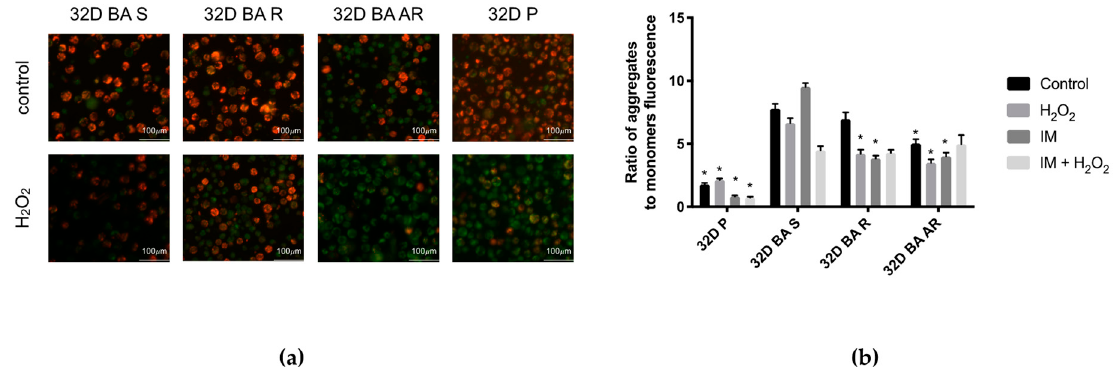
Figure 3. Mitochondrial membrane potential in BCR-ABL1 cells. ( a ) Photos showing leukemic and wild-type, non-cancer cells under different conditions of treatment: control and after 30-min exposure to H 2 O 2 . We stained the cells with cationic dye JC-1 that accumulates in the mitochondrial membrane in a potential-dependent manner. A high potential of the inner mitochondrial membrane leads to the formation of dye aggregates with both excitation and emission shifted towards the red light (530 nm/590 nm), while respective values for JC-1 monomers are 485 nm/538 nm; ( b ) A comparison of the measured ratio in aggregate/monomer ratios of cationic dye JC-1. In BCR-ABL1 positive and parental 32D cells under control conditions and after treatment with IM, H 2 O 2 or IM + H 2 O 2 . We cultured cells with IM for 24 h and with H 2 O 2 for 30 min; in case of co-incubation H 2 O 2 was added at the end of IM incubation. IM was used in 1 µM concentration and H 2 O 2 in 100 µM. We measured MMP as a ratio of JC-1 monomer to aggregates with a fluorescent plate reader. * p < 0.05, the asterisk indicates a significant difference after treatment between a given line and the 32D BA S line, n = 4, results shown as mean ± SEM.